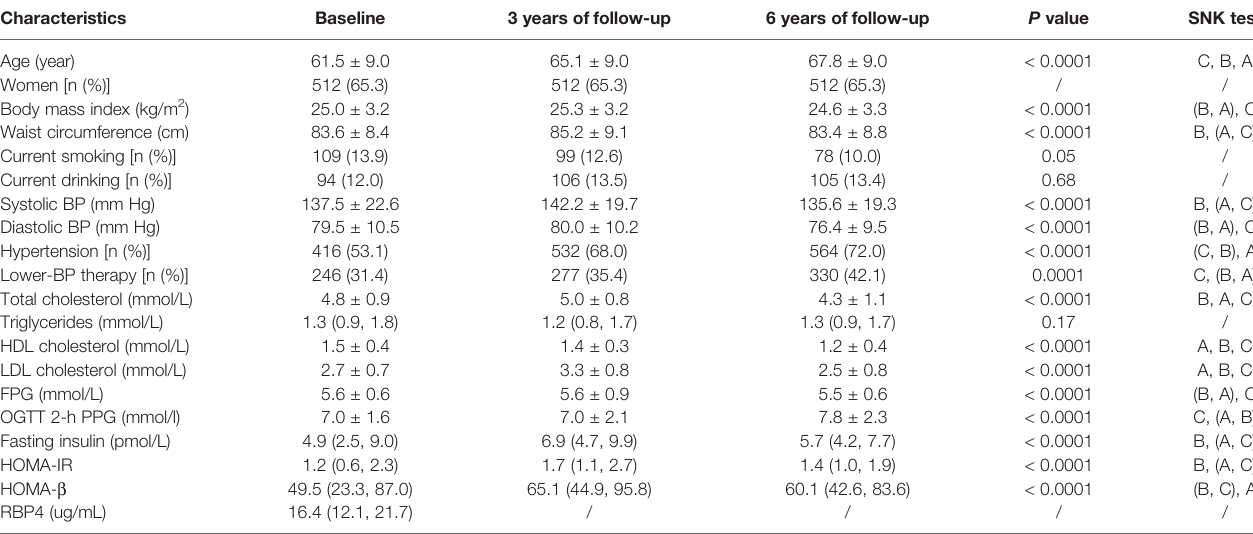
TABLE 1 | Characteristics of participants in the longitudinal study with follow-up at 3 and 6 years, respectively (n = 784). Characteristics Baseline 3 years of follow-up